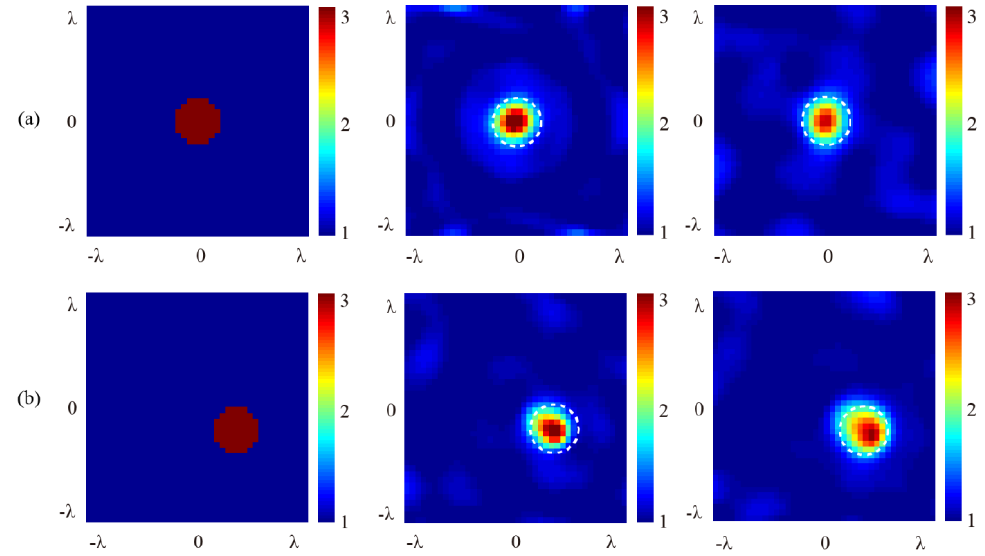
Figure 11. Retrieved results with experimental data for 15° and 30° angles of incidence. ( a ) Center-located target; and ( b ) off-center located target.